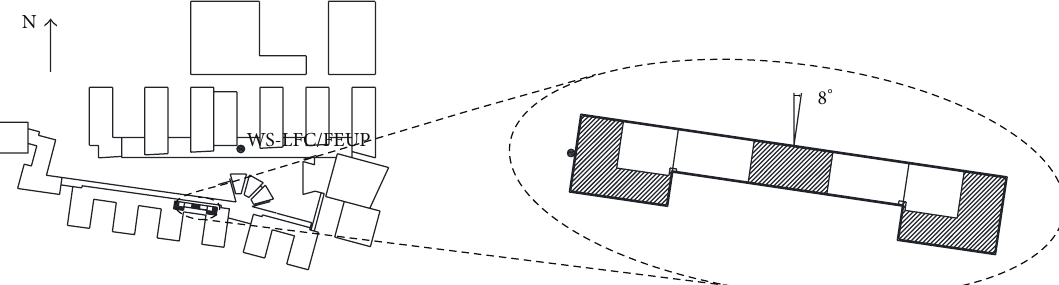
Figure 7: Layout with the surface devices and weather station locations.